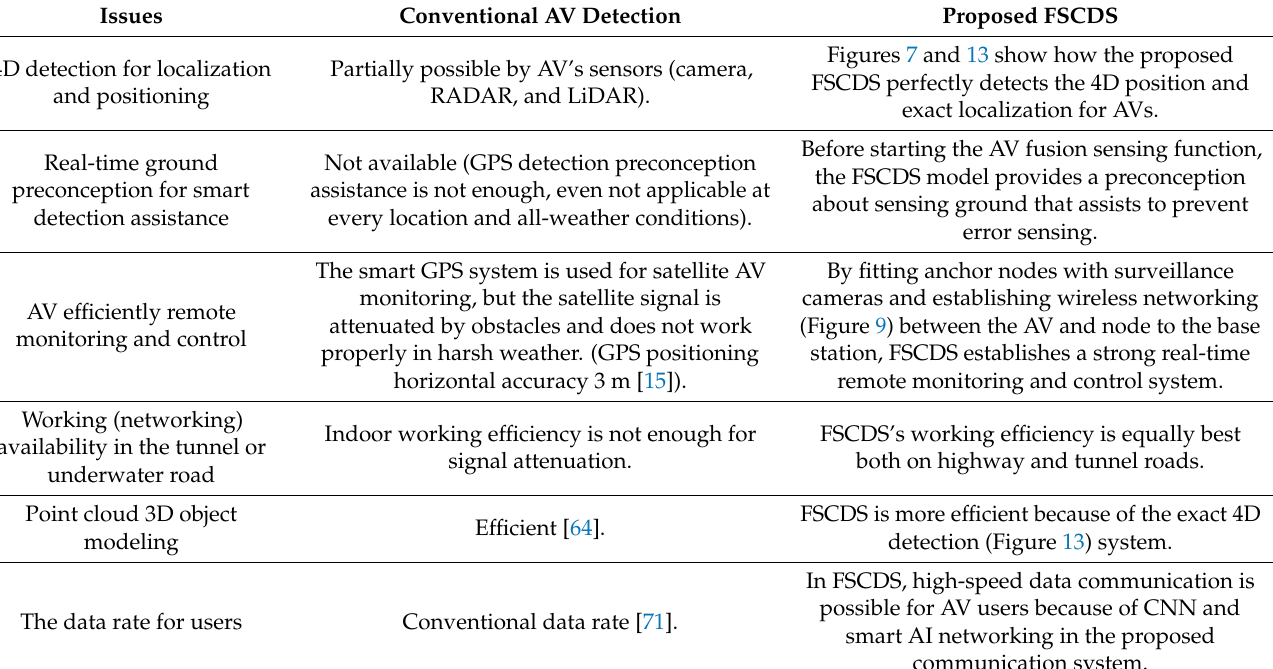
Table 4. Compressional performance analysis of traditional fusion and the proposed FSCDS.